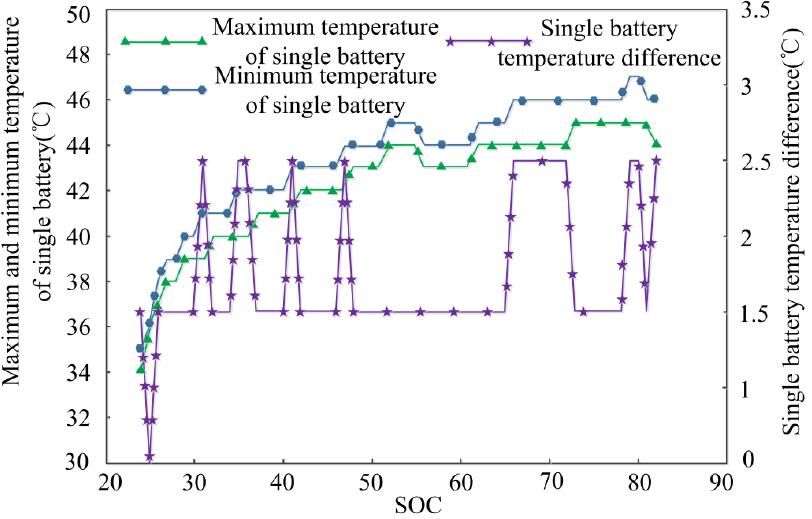
Figure 10. The maximum temperature of the single cell, minimum temperature of the single cell, and temperature difference of the single cell vary with SOC. temperature difference of the single cell vary with